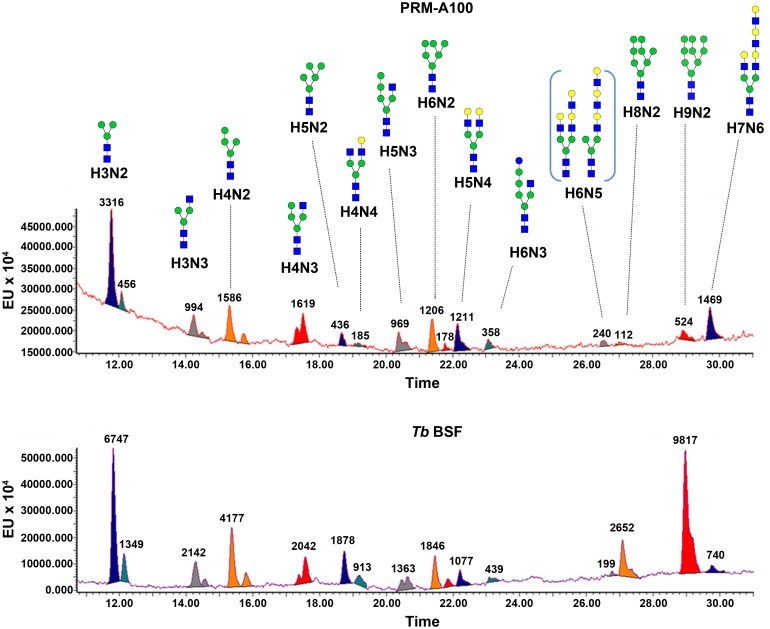
Analysis of N-glycans from PRM-A100-resistant sVSG221.Integrated UPLC-FLD chromatograms of procainamide labelled glycans from resistant (PRM-A100) and control (Tb BSF) N-glycan samples labelled with procainamide.